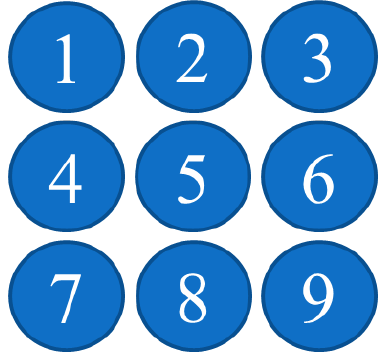
Figure 6. Top view of the 3 × 3 cymbal array.